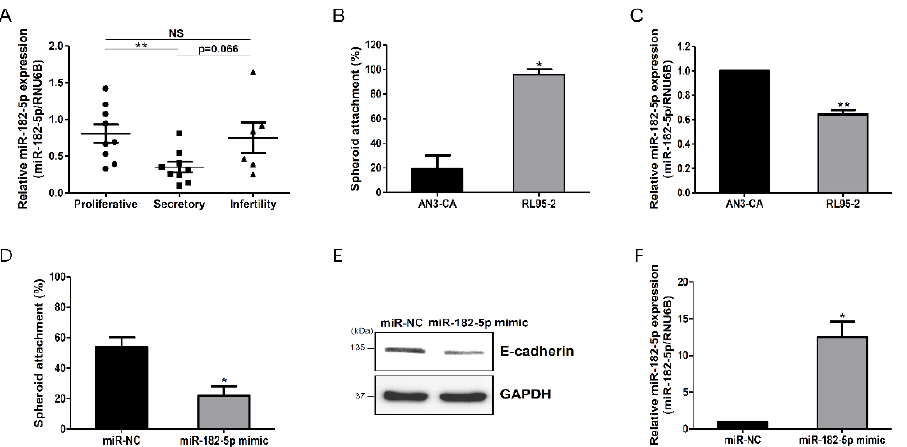
Figure 1. miR-182-5p inhibited the receptive ability of endometrial epithelial cells. ( A ) Analysis of miR-182-5p expression during the proliferative and secretory phases, and the infertile secretory phase of endometrial tissues. ( B ) Assessment of spheroid attachment to non-receptive AN3-CA cells or receptive RL95-2 cells. ( C ) Analysis of miR-182-5p expression in AN3-CA and RL95-2 cells. ( D ) Spheroid-attachment rate of RL95-2 cells transfected with an miR-182-5p mimic. ( E ) Effect of the miR-182-5p mimic on E-cadherin protein expression in RL95-2 cells. ( F ) Confirmation of miR-182-5p expression in RL95-2 cells transfected with the miR-182-5p mimic. The data shown represent the mean ± standard error of the mean (SEM) from three independent experiments (n = 3). * p < 0.05; ** p < 0.01; NS: not significant.